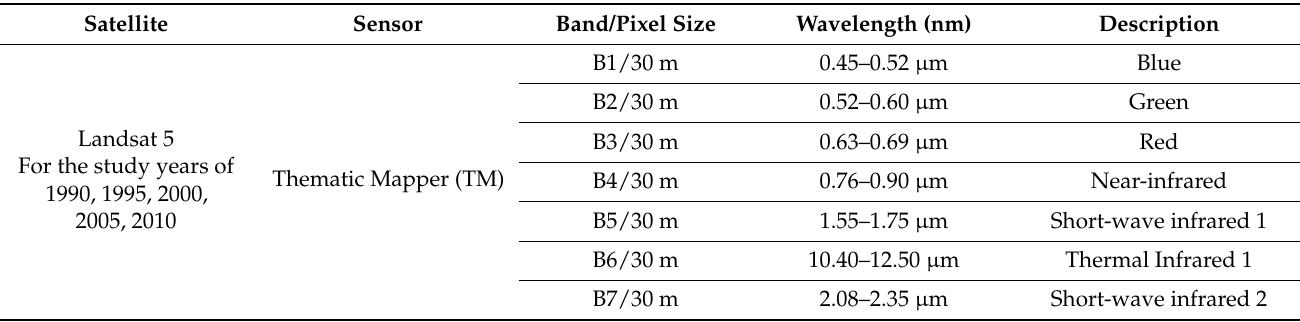
Table 1. Landsat5/8 bands and their characteristics used to select the relevant soil salinity indices based on their spectral characteristics and